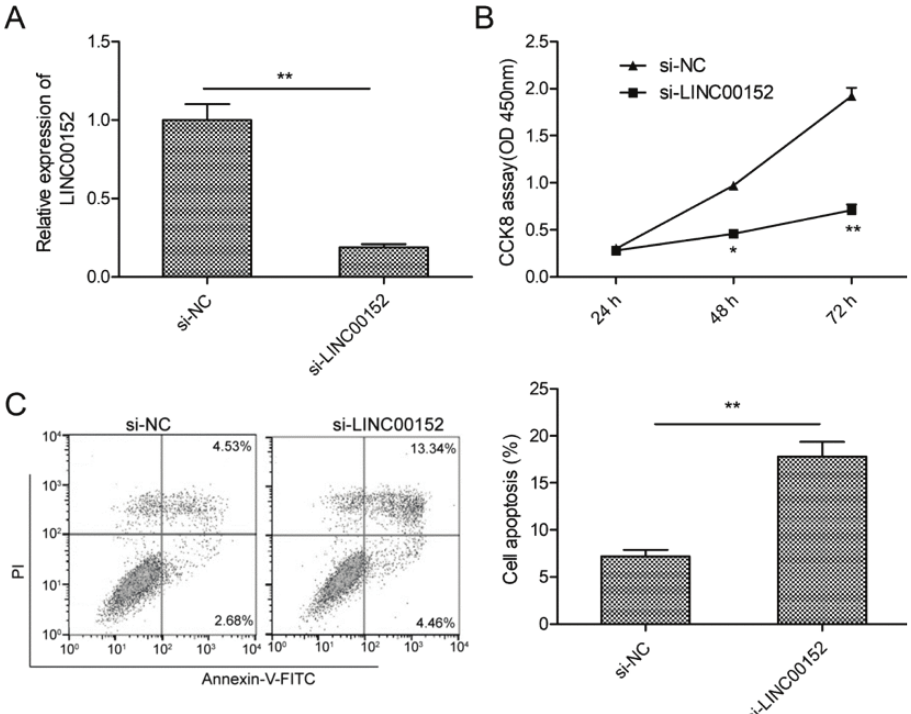
Figure 2: LINC00152 depletion inhibits cell proliferation and induces apoptosis of LSCC cells. (A) The transfected efficiency of si-NC and si-LINC00152 was confirmed in TU212 cells through qRT-PCR. (B, C) The proliferation and apoptosis of TU212 cells transfected with si-LINC00152 or si-NC were examined by CCK8 and flow cytometric assays, respectively. **P< 0.01.